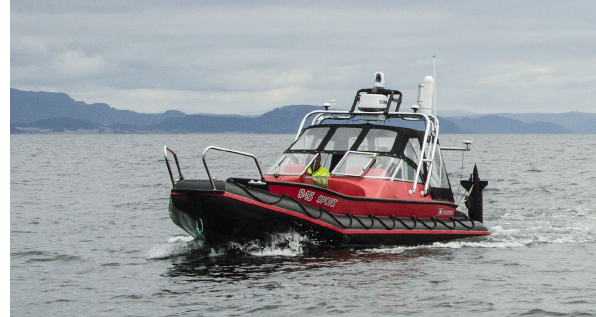
Figure 8: The Telemetron ASV, owned and operated by Mar- itime Robotics. Courtesy of Maritime Robotics.